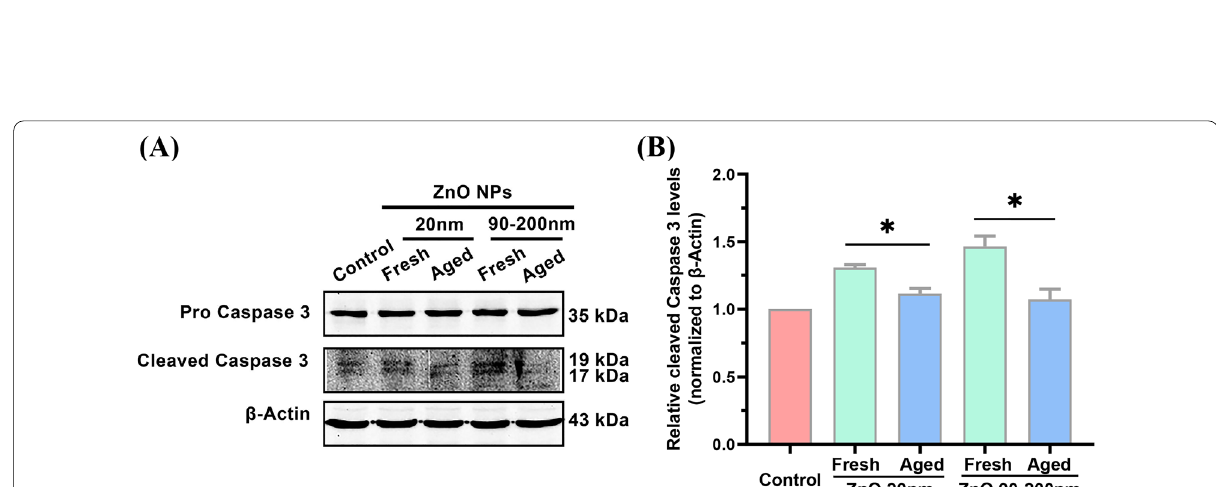
Fig. 6 Apoptotic levels in A L cells incubated with fresh and aged ZnO NPs (20 and 90–200 nm). Western Blotting analysis ( A ) and quantification ( B ) of cleaved Caspase 3 protein levels when cells were incubated with 12 μg/mL fresh and aged ZnO NPs (20 and 90–200 nm) for 72 h. Data were based on 3 independent experiments and expressed as mean ≥